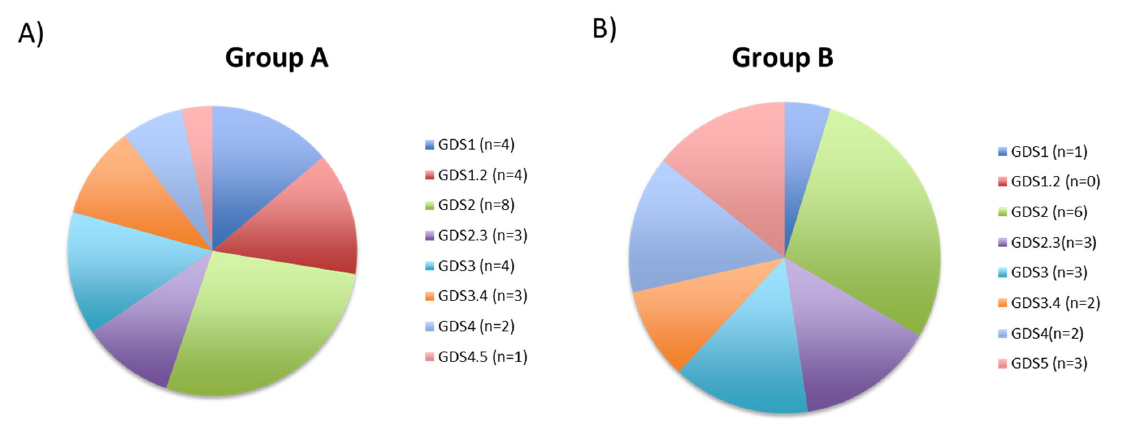
Figure 7. Pie charts depicting the relationship between GDS stages and levels of global DNA meth ‐ ylation (5mC) in ( A ) patients ( n = 29; Group A) whose 5mC levels were found to be higher during the follow ‐ up consultation than during the initial visit, and ( B ) patients ( n = 21; Group B) whose 5mC levels did not increase during the follow ‐ up versus the initial visit. GDS stages 1 and 2 indicate normal cognitive function, and higher GDS stages indicate progressive cognitive impairment. 5mC, 5 ‐ methylcytosine; GDS, Global Deterioration